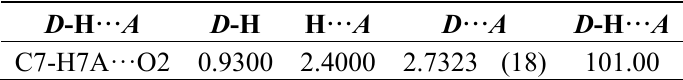
Table 3. Hydrogen-bond geometry (Å, °) of compound 1a .